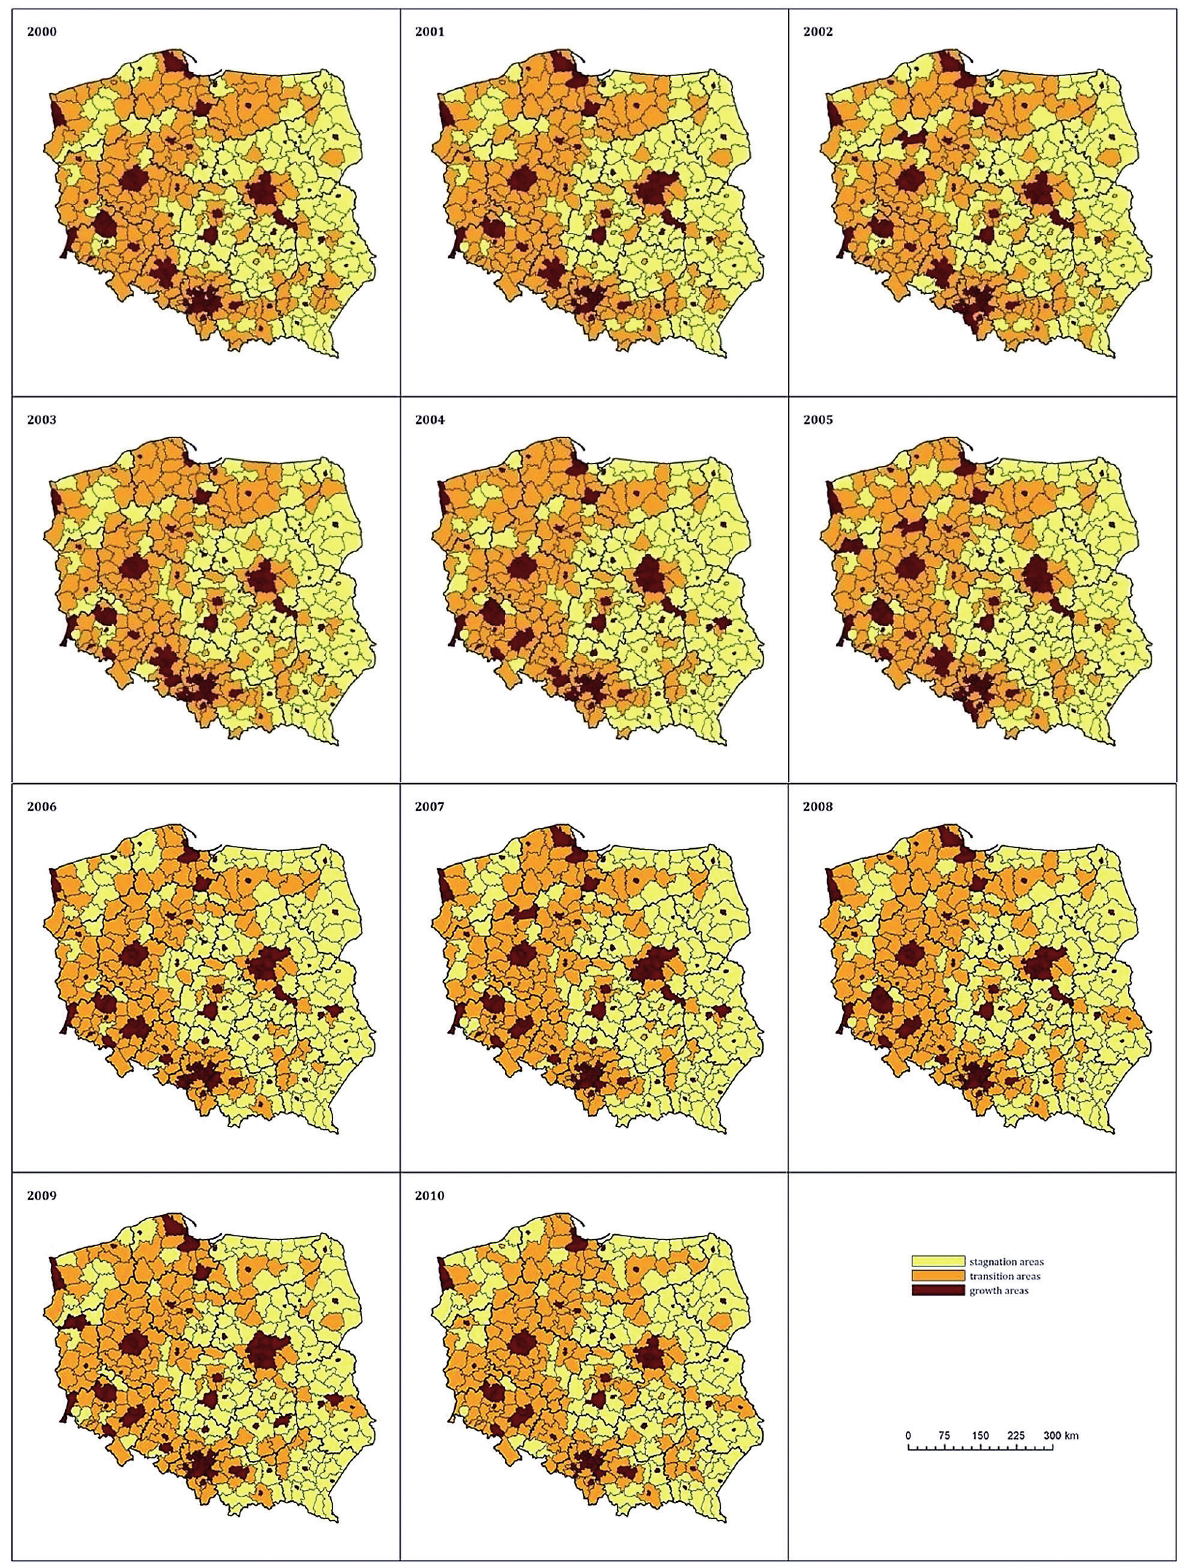
Fig. 2. Distribution of areas of economic growth and stagnation at the local (NUTS 4) level in the years 2000–2010: a general approach Source: own